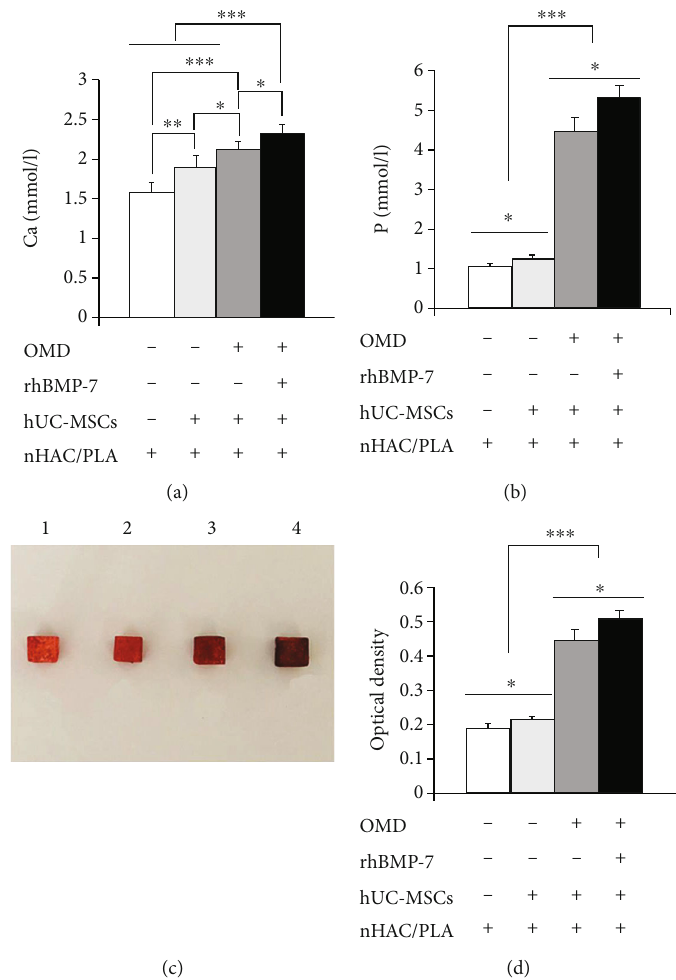
Figure 8: Ca concentration, P concentration, and mineralized matrix formation in the in vitro three-dimensional culture microenvironment for 14 days ( mean ± SD , n = 6 ). (a) Ca. (b) P. (c) Alizarin Red staining. (c-1) nHAC/PLA. (c-2) hUC-MSCs+nHAC/PLA. (c-3) hUC-MSCs +nHAC/PLA+OMD. (c-4) hUC-MSCs+nHAC/PLA+OMD+rhBMP-7. (d) Mineralized matrix formation. ∗ P < 0 : 05 , ∗∗ P < 0 : 01 , ∗∗∗ P < 0 : 001